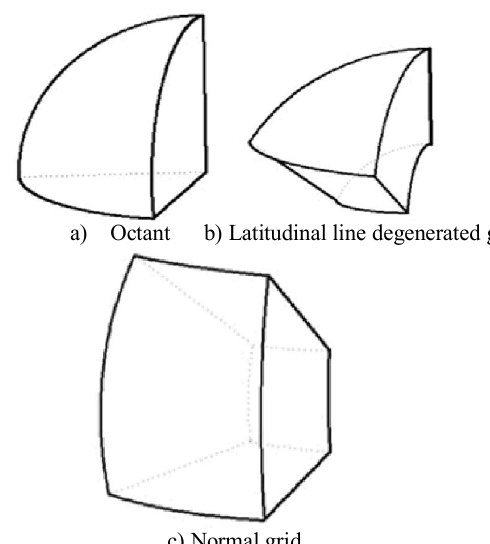
Figure 3. Three basic grids of sphere degenerated